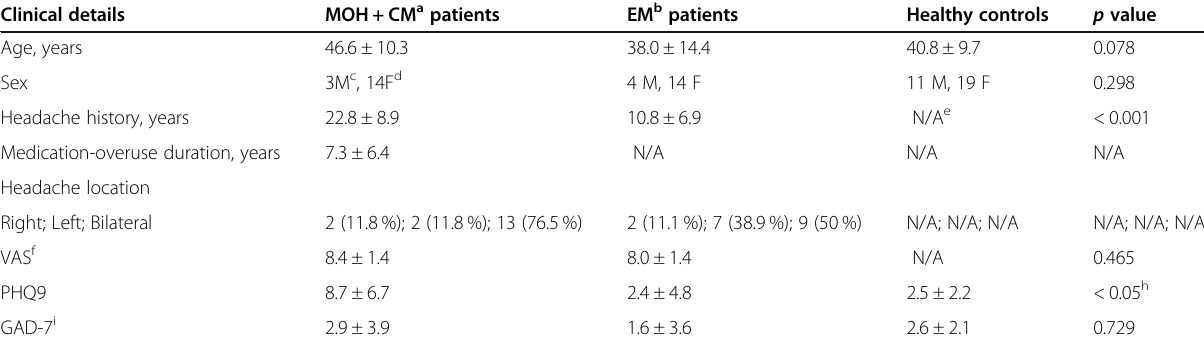
Table 1 Demographic and clinical data for all participants Clinical details